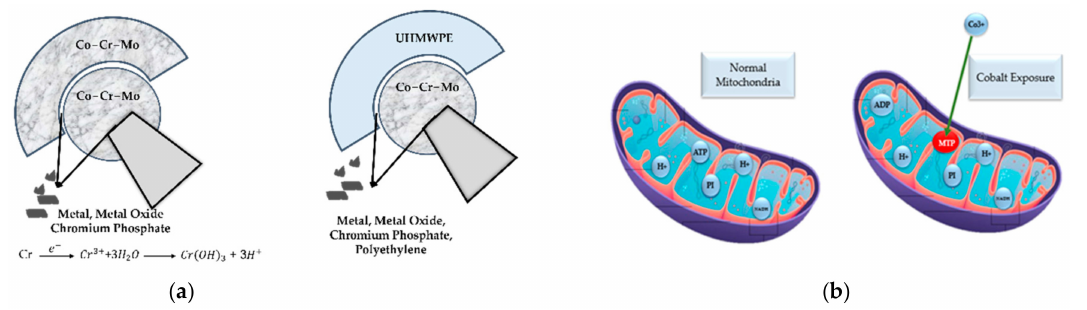
Figure 11. ( a ) Different wear debris generation and associated chemical reactions at hip implant joints, and ( b ) presence of cobalt ions in